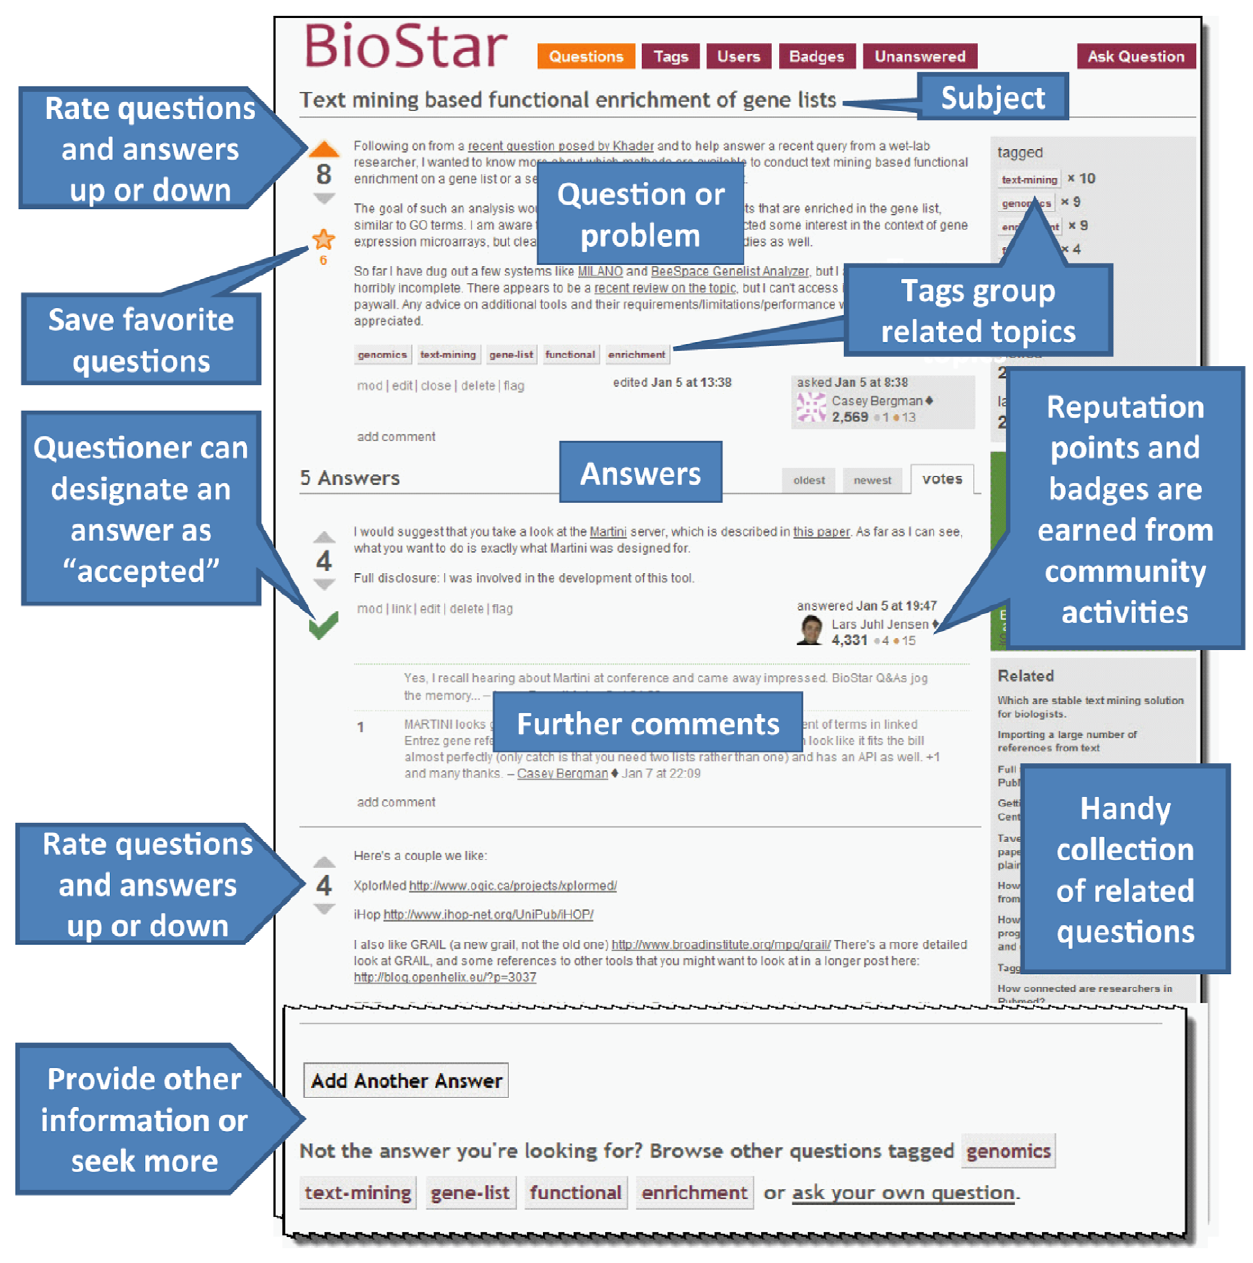
Figure 2. A typical discussion at BioStar. Discussion begins with a query, generates various answers, and yields additional comments that can lead to further information. Community voting on questions and answers contributes to reputation points and badges earned by users, along with activities such as editing and other types of participation. Question tags and automatically generated ‘‘related’’ questions can lead to further exploration of a topic. BioStar allows for additional answers to be appended at any time. Some questions acquire community ‘‘wiki’’ status if the issue is better served by a group discussion than by a discrete answer.